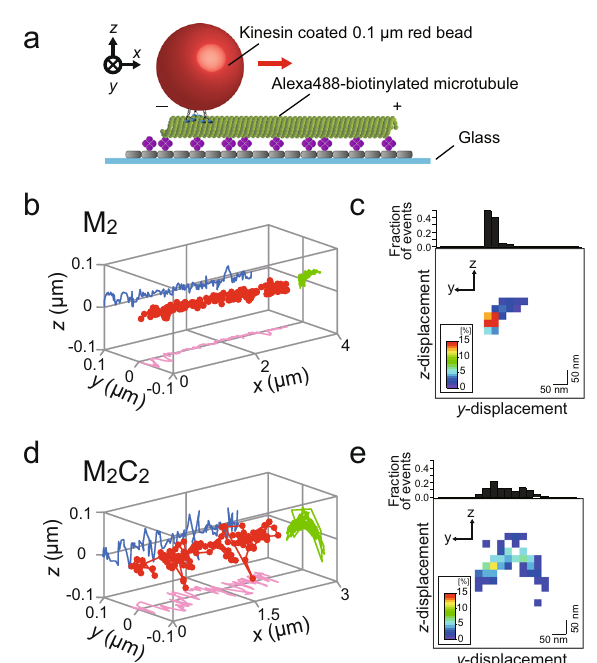
Fig. 6 Continuous rotational movement displayed by M 2 C 2 in a spatially restricted environment. a Schematic representation of the experimental geometry. The biotinylated, Alexa488-labeled taxol stabilized microtubule was attached to the biotinylated BSA (gray)-coated coverglass via streptavidin (purple). Using tPOT , the MKLP1-coated bead movements on the non-suspended microtubule were quanti fi ed. b A 3D trace of an M 2 - coated bead moving along the coverglass surface-immobilized microtubule. Initially, the M 2 -coated bead showed a left-handed rotation. After reaching the left edge of the microtubule and contacting the glass surface, the M 2 - coated bead suspended the rotational motion although it continued the longitudinal motion. c Bivariate histogram showing normalized distribution of the y – z location of the bead shown in b . The colors indicate the frequency of fi nding the bead in each 25 nm square on the y – z projection. M 2 showed limited rotational motion on the coverglass surface-immobilized microtubule. d A 3D trace of M 2 C 2 -coated bead along a microtubule immobilized on the coverglass surface. Upon reaching the left edge of the microtubule and contacting the glass surface, the bead often reversed rotational direction and continued the rotational motion. e Bivariate histogram showing normalized distribution of the y – z location of the bead shown in d